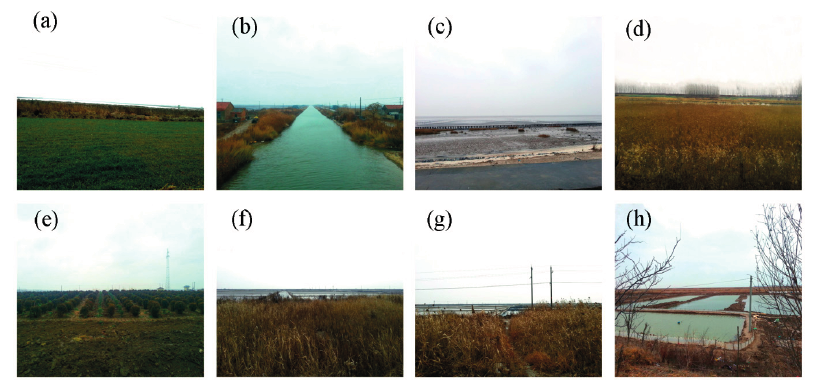
Figure 2. Photographs of eight typical land cover types taken in the study area. ( a ) Grassland; ( b ) river; ( c ) sand; ( d ) paddy rice; ( e ) irrigable land; ( f ) wetland vegetation; ( g ) dry land; and ( h ) fish